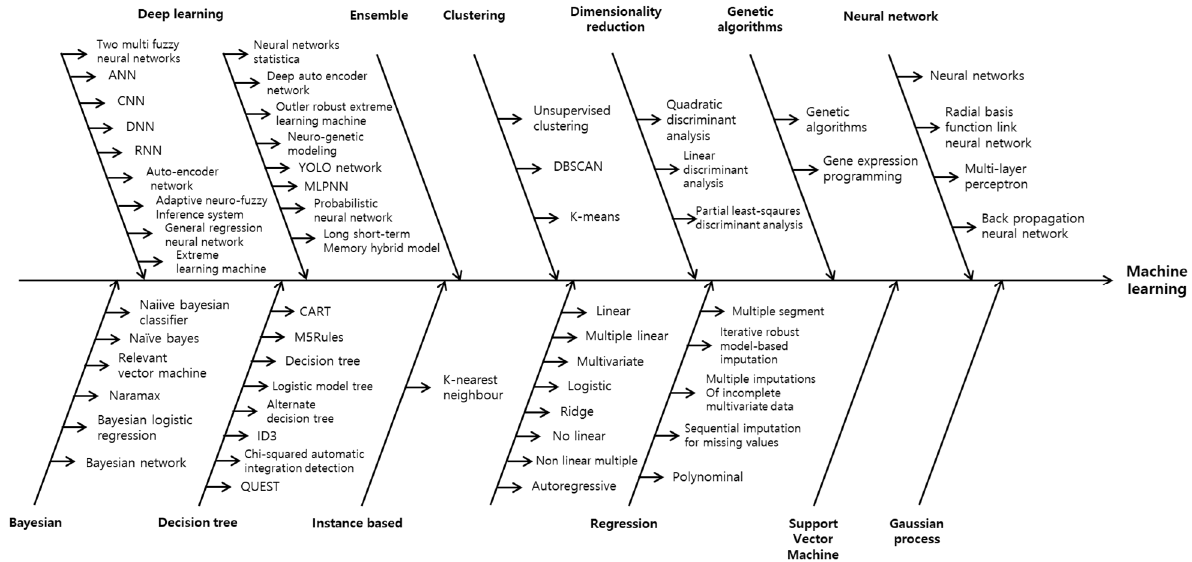
Figure 7. Classification of ML techniques. ANN: artificial neural network, CNN: convolutional neural network, DNN: deep neural network, RNN: recurrent neural network, DBSCAN: density-based spatial clustering of applications with noise, YOLO: you only look once, MLPNN: multiple-layer perceptron neural network, CART: classification and regression tree, ID3: iterative dichotomiser 3, QUEST: quick unbiased efficient statistical tree algorithms.